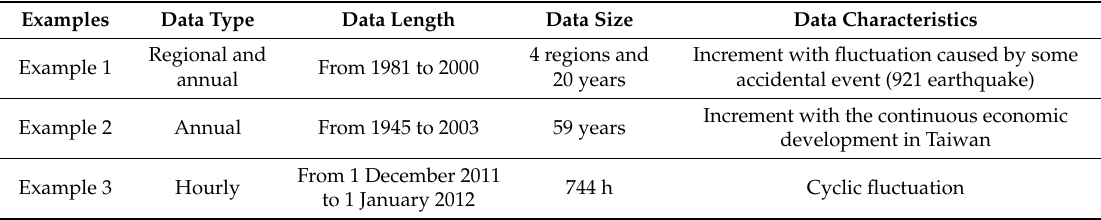
Table 1. Data characteristics summary of three